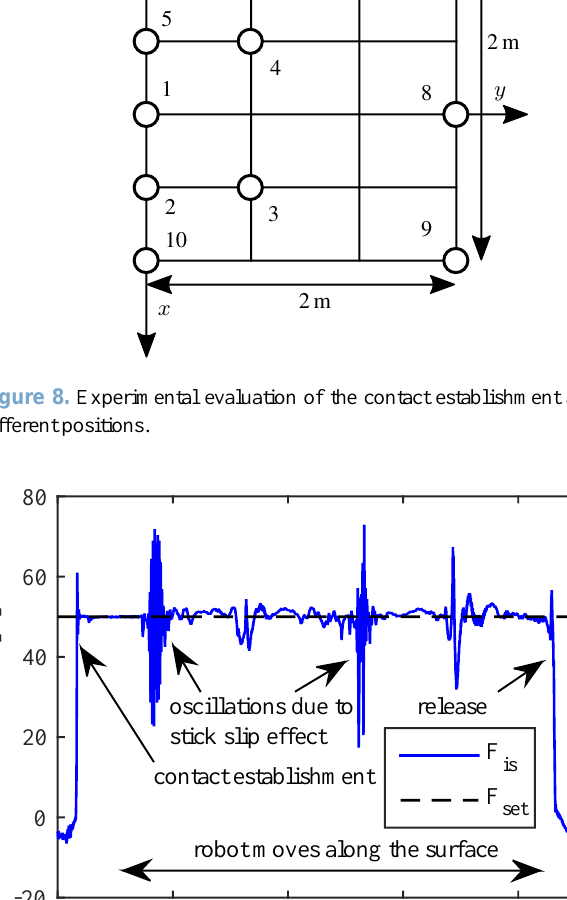
Table 2. Experimental evaluation of the contact establishment at different positions and resulting overshoot and settling time.